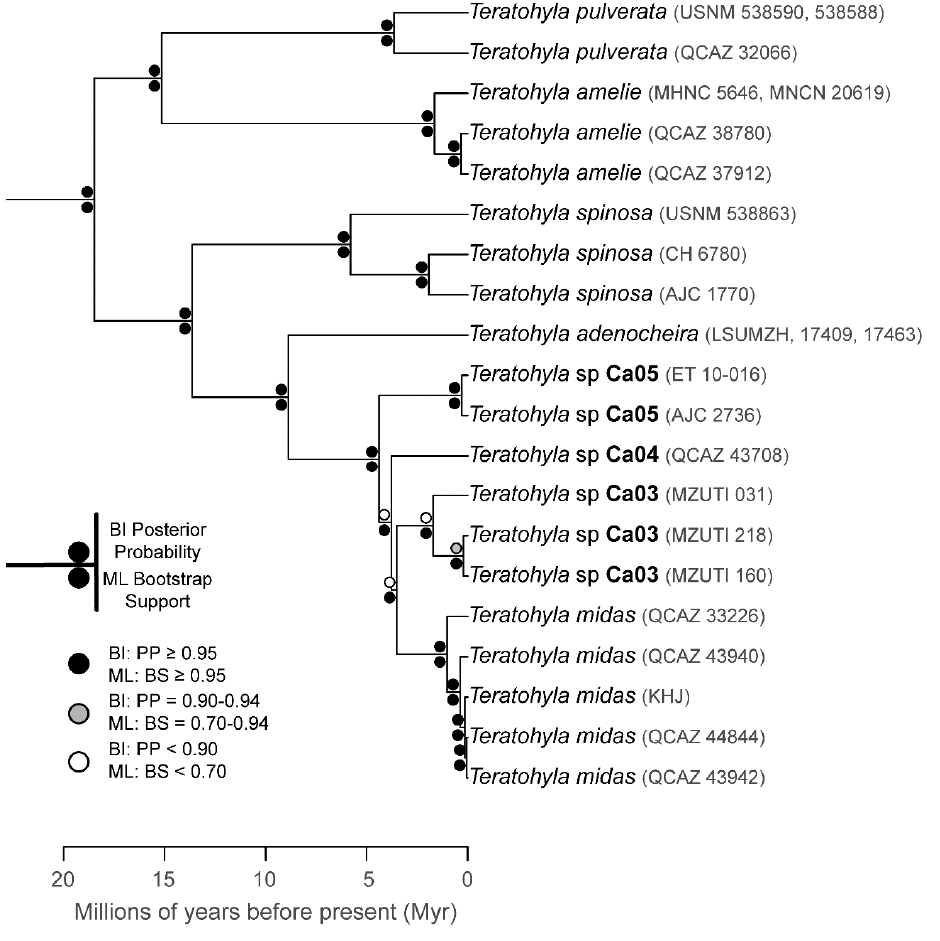
Figure 210. Evolutionary relationships of species in the glassfrog genus Teratohyla . The trees were inferred using maximum likelihood and Bayesian criteria.